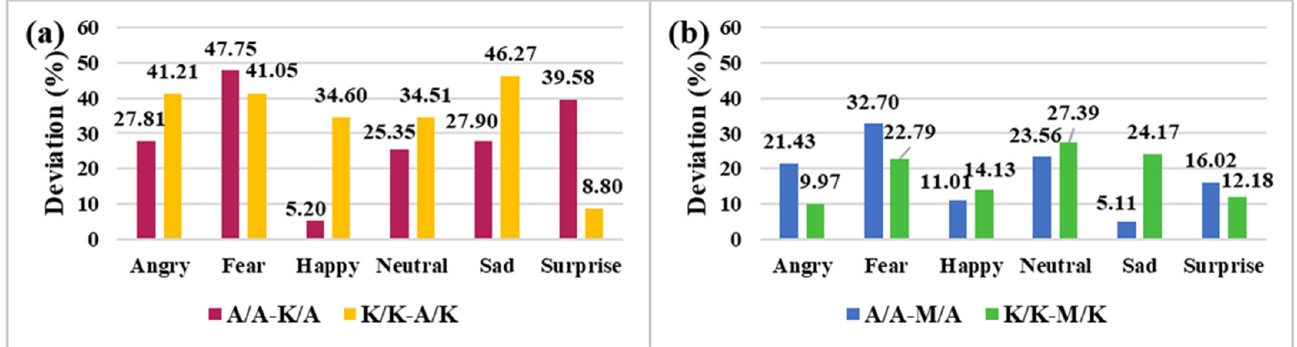
Figure 9. Accuracy deviation between age-specific and nonage-specific of SE-ResNeXt50 (32 × 4 d): ( a ) deviation between the age-specific and opposite-age groups, ( b ) deviation between the age-specific and mixed-age groups.